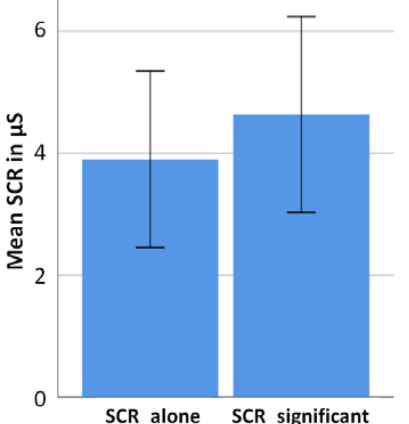
Figure 5. Bar diagram (including standard deviations) showing mean SCR values across all partici- pants ( N = 19) for both experimental conditions (alone and significant other conditions). The arousal level is significantly higher in the significant other condition compared to the alone